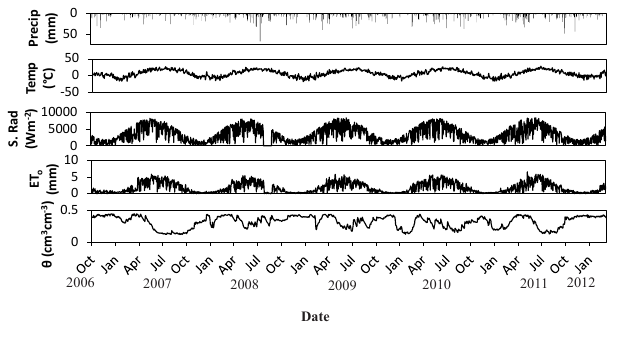
Fig. 2. Daily time series plot of 10cm site averaged soil moisture from K1 and daily time series of meteorological data collected at Kelso.